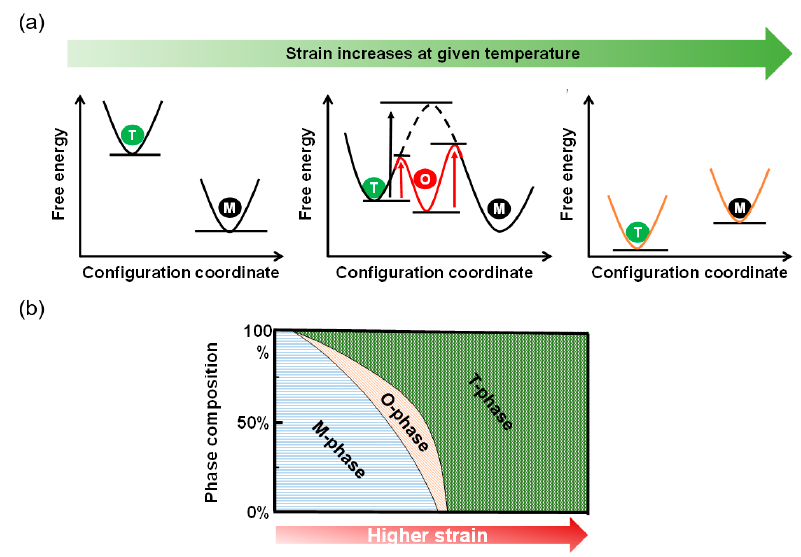
Figure 7. ( a ) Free energy diagram with different strains at a given temperature which determines phase composition in HfO 2 film. ( b ) The schematic diagram of the mechanism for general parameters influencing phase stability in HfO 2 films.